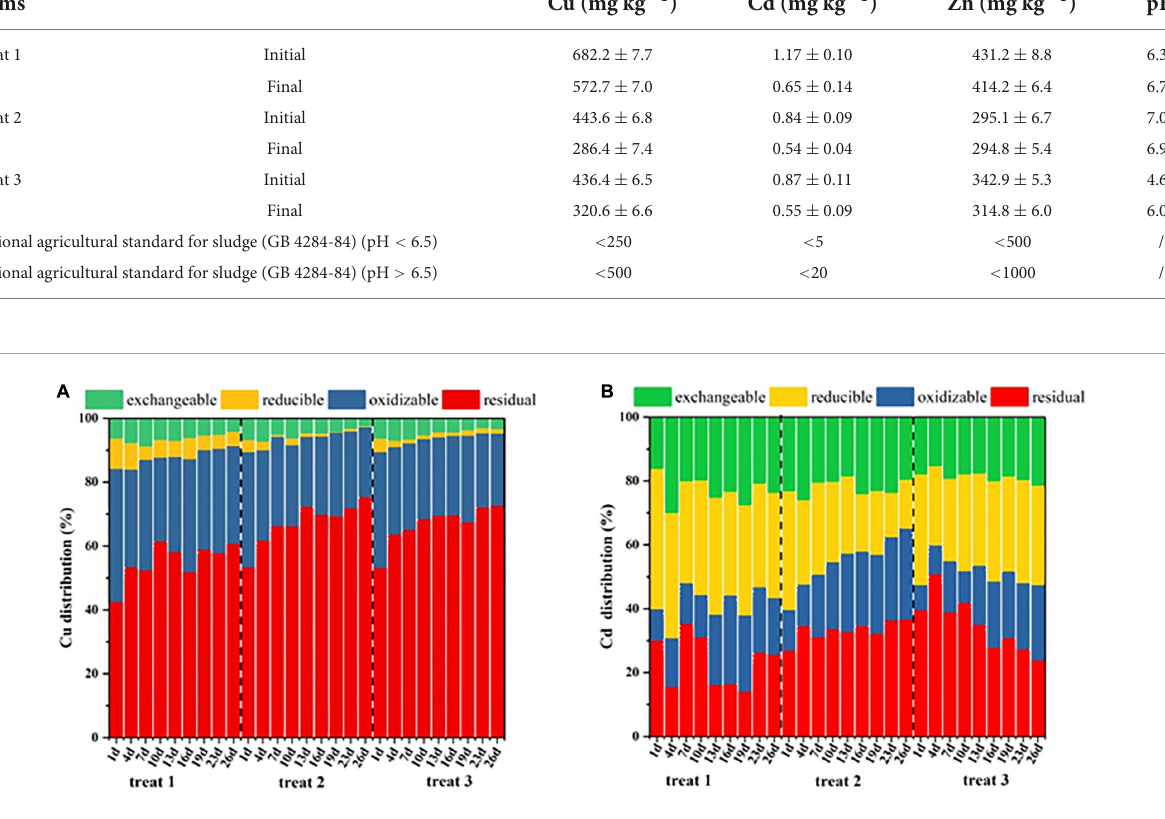
might be caused by the loss of more filtrate in the pile after the addition of the composting bacterial agent. As